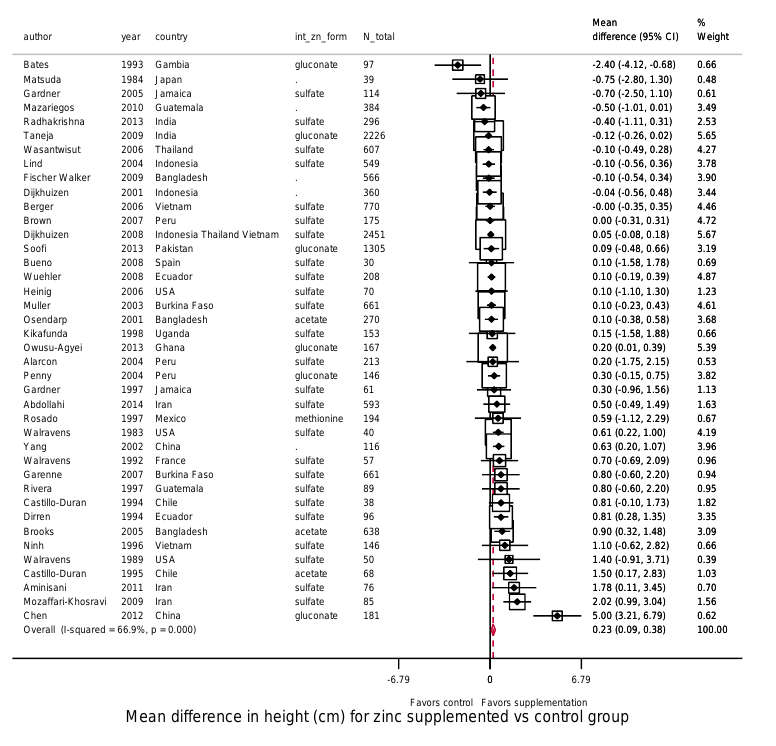
Figure 1. Effect of zinc supplementation among children aged < 5 y old on height in randomized F igure 1: Effect of zinc supplementation among children aged<5 y old on height in randomized controlled controlled trials.